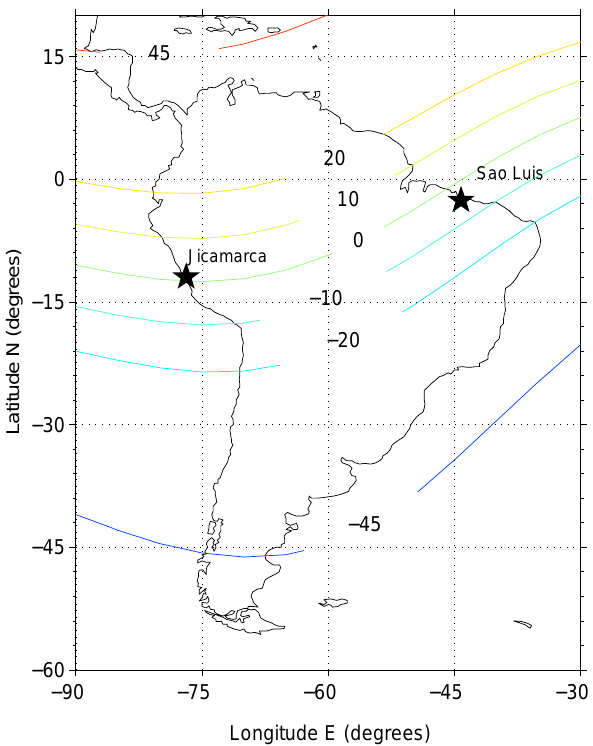
Fig. 1. Location of the S˜ao Lu´ıs radar. Contours of magnetic in- clination and the location of the Jicamarca radar in Peru are also shown for reference.